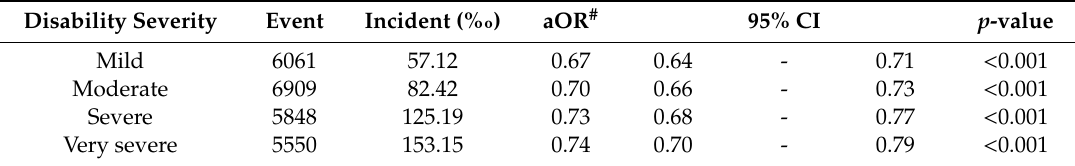
Table 3. Stratified analysis to compare the risk of death in individuals with di ff erent severities of disability between the vaccinated and unvaccinated cohorts. Disability Severity Event Incident (% (cid:24) ) aOR #